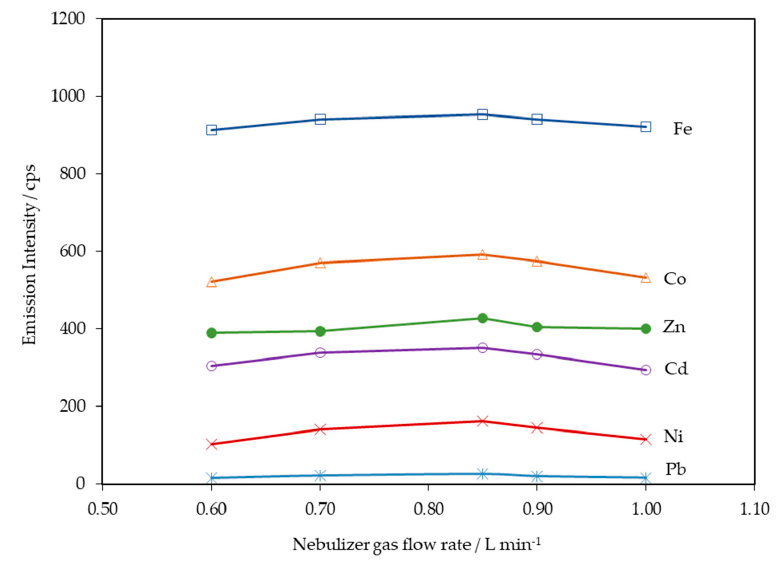
Figure 1. Effect of nebulizer gas flow rate on the emission intensity of 0.5 mg L − 1 Fe, Co, Zn, Cd, Ni, and Pb. All other parameters are presented in the text.